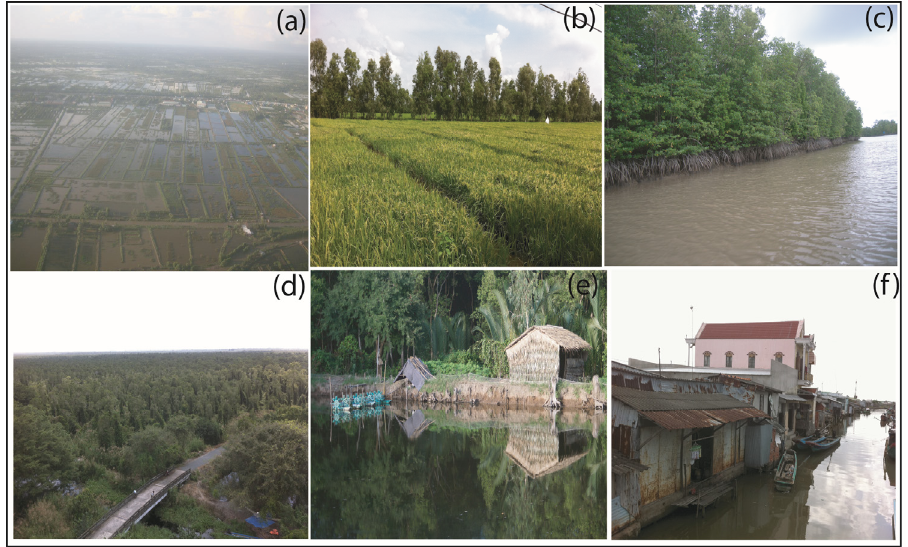
Figure 4. Pictures from the field in the Tran Van Thoi District ( a ) Lowland Ca Mau from airplane; ( b ) Paddy rice; ( c ) Mangrove forest; ( d ) Melaleuca forest; ( e ) Aquaculture pond; and ( f ) Specific houses in the study